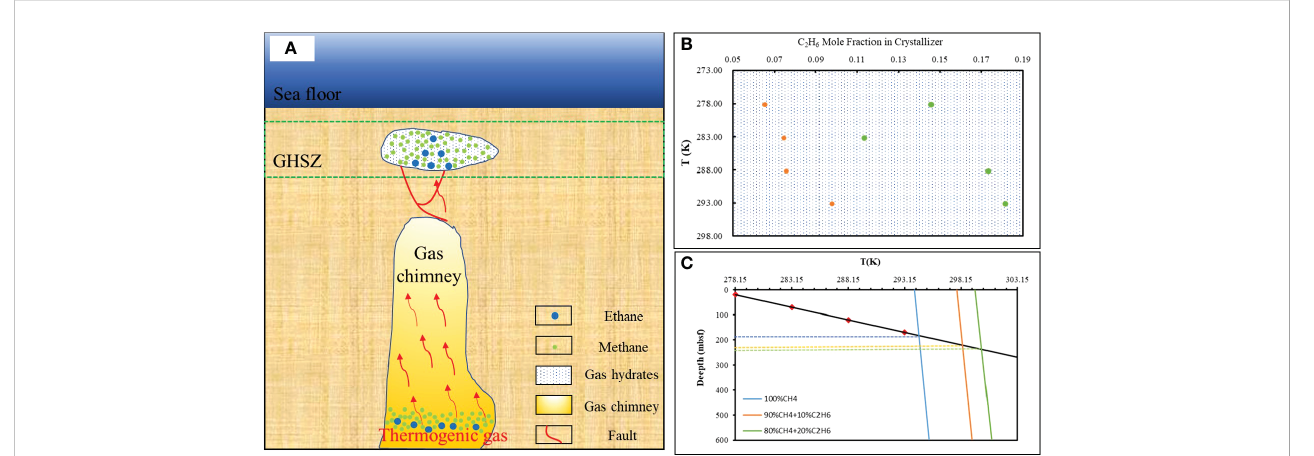
FIGURE 8 A proposed simpli fi ed model of the thermogenic dissolved gas hydrate accumulation mechanism. (A) Red arrow represents thermogenic gases, red lines indicate faults tectonic, and white represents hydrates. (B) The proportion of ethane in hydrates varies with temperature. Orange represents the gas source composition of 90% CH 4 + 10% C 2 H 6 , green represents the gas source composition of 80% CH 4 + 20% C 2 H 6 . (C) The base of the gas hydrate stability zones was calculated by pure methane, and methane and ethane gases used in this study. The geothermal gradient is calculated by 100°C/km, an average value measured using the Guangzhou Marine Geological Survey (GMGS5) Site W9 (GMGS5-W9) hydrate system with gas chimneys (Liang et al., 2019).